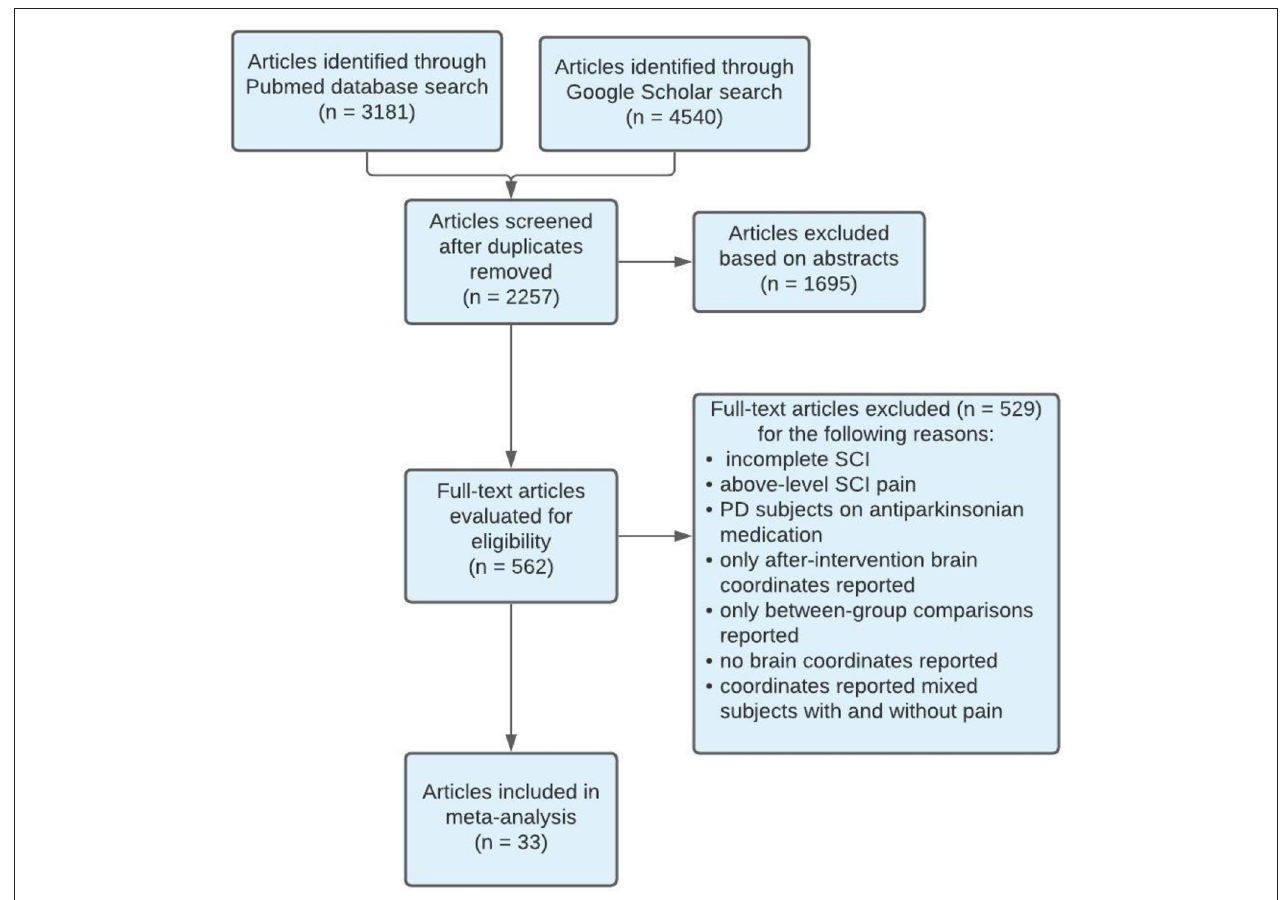
FIGURE 2 | PRISMA flow diagram of search methodology for articles included in meta-analysis. SCI, Spinal Cord Injury; PD, Parkinson’s disease.